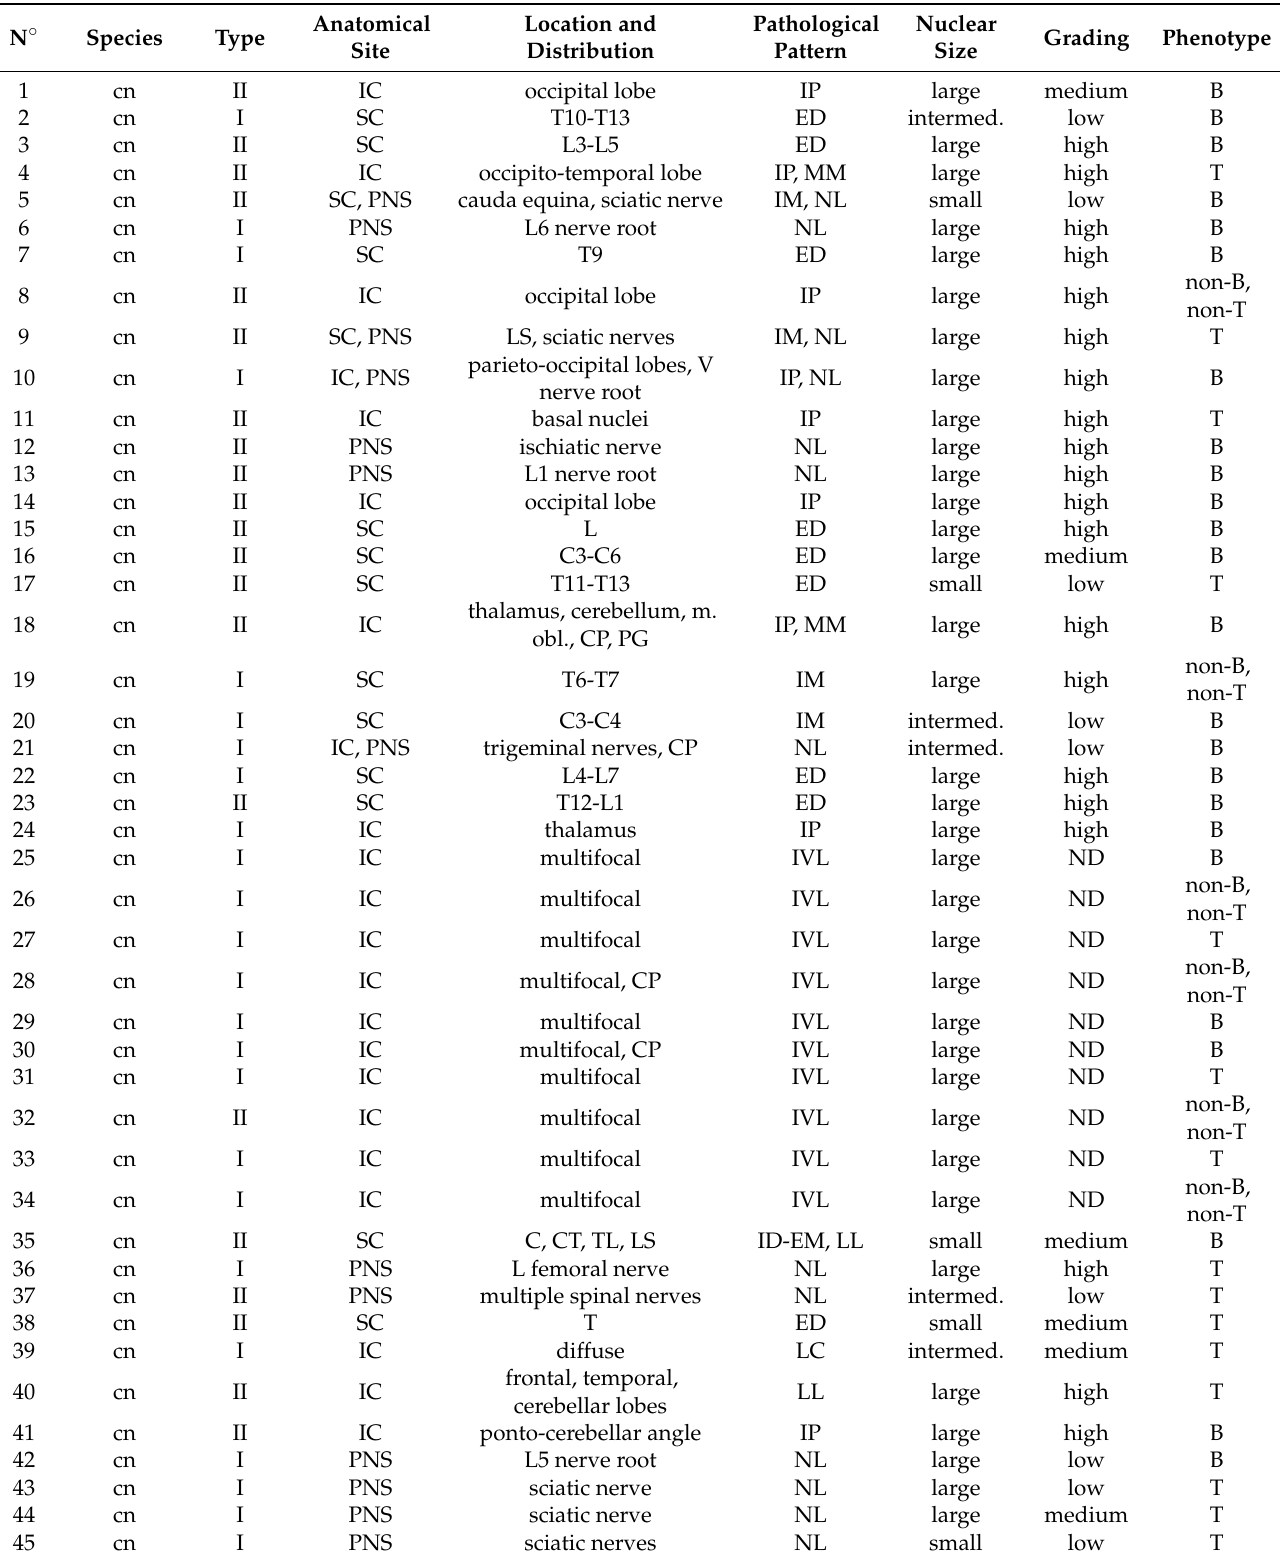
Table 2. Type, anatomical site, location, distribution, pathological pattern, nuclear size, grading, and phenotype of nervous system lymphoma in 92 canine and feline